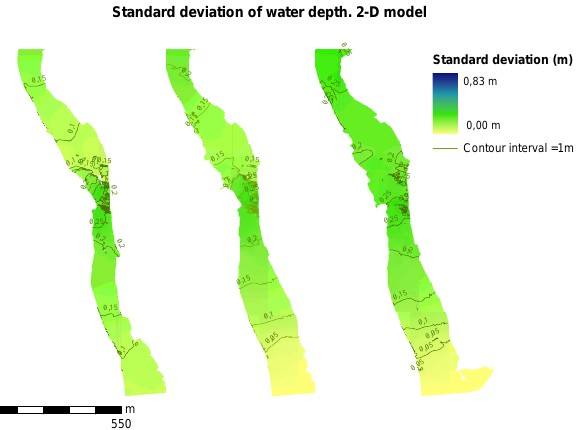
Fig. 17. 2-D SWE model. Flood maps with standard deviation values of velocities predicted by point-estimate method for flow cases of 200m 3 s − 1 (left panel), 300m 3 s − 1 (middle panel) and 500m 3 s − 1 (right